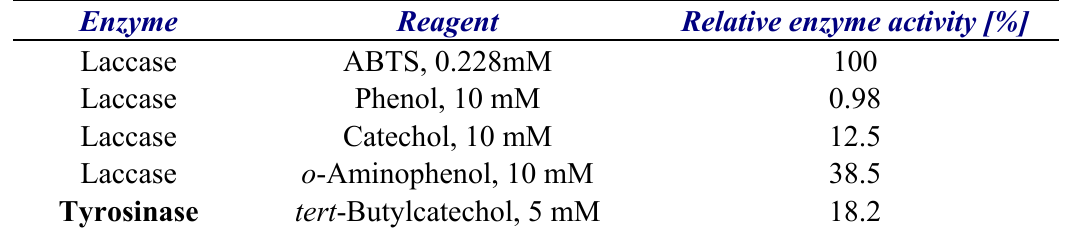
Table 4. Immobilized proteins activity in presence of various phenolic compounds